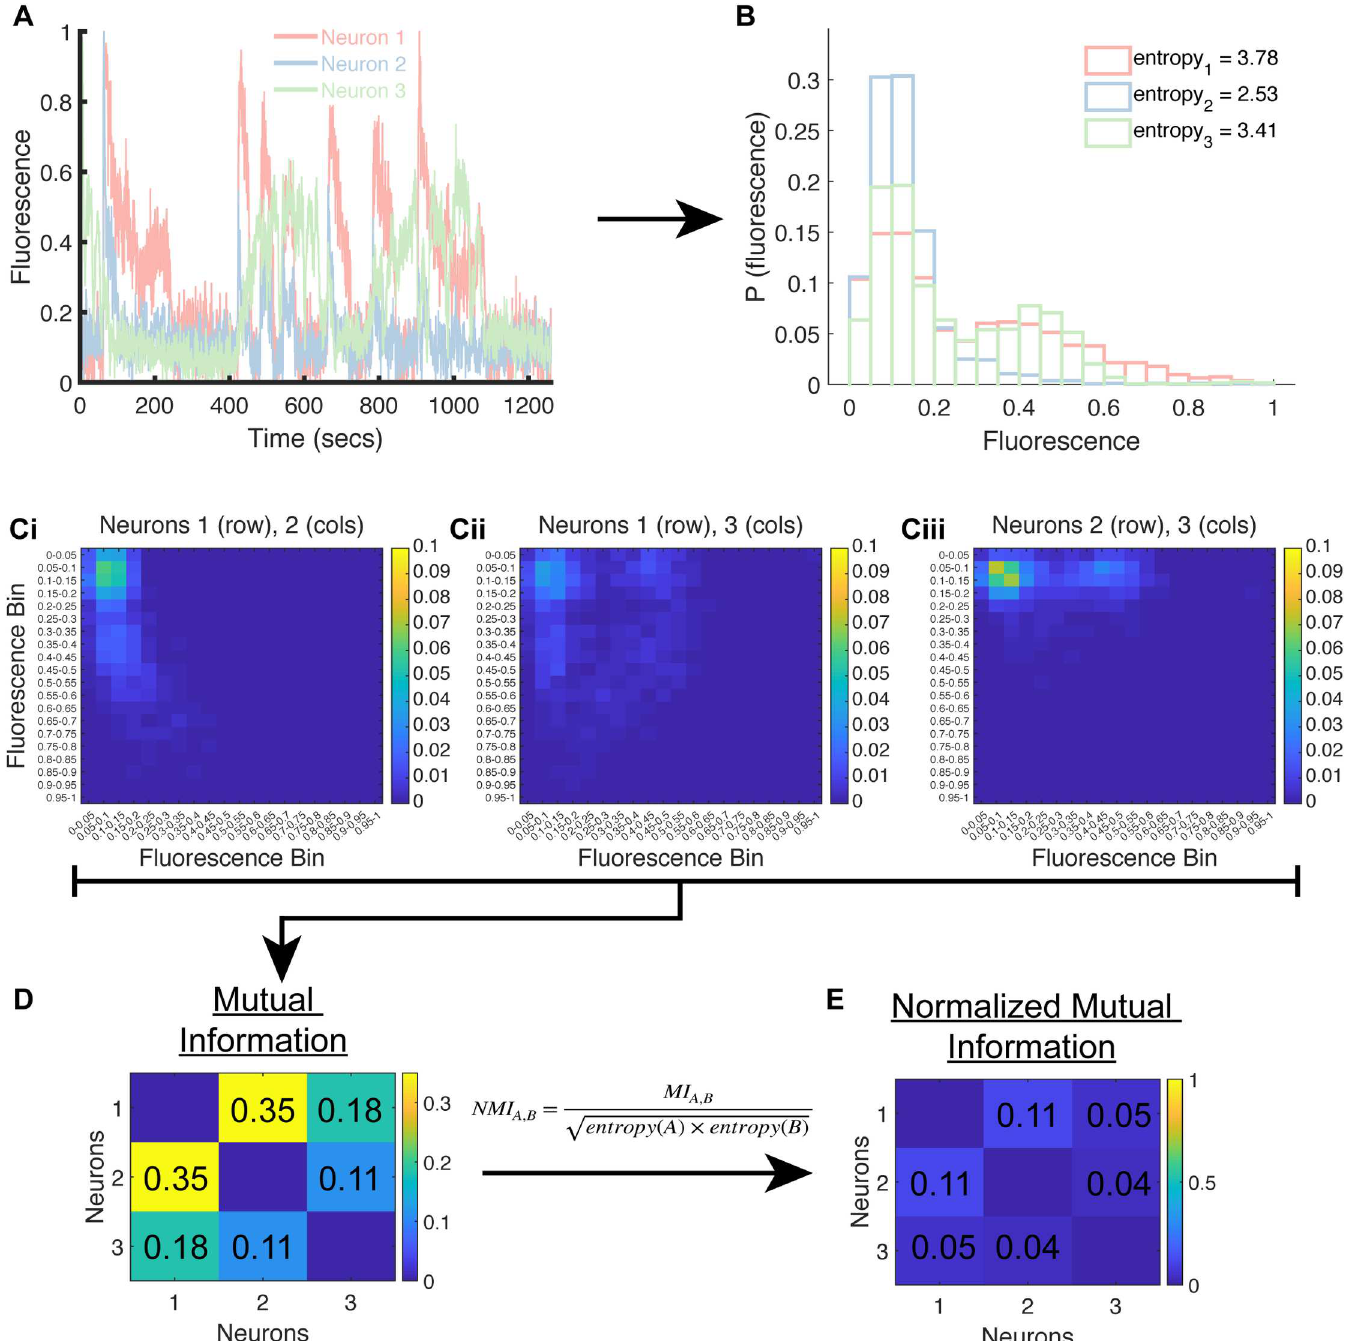
Fig 3. Example of generating an adjacency matrix from the time-series activity of three neurons. A) Activity of three neurons from one worm experiencing 10 − 2 2-nonanone. The three traces are normalized to their max (i.e., each trace is divided by the maximum fluorescence value it achieved in the 21-minute long imaging session). B) Time series are binned into histograms using bins of size 0.05. The legend shows the entropies of the histograms of each neuron from panel A. C) The joint probability distributions of the histograms in panel B for: Ci) Neuron 1 (rows) and Neuron 2 (columns), Cii) Neuron 1 (rows) and Neuron 3 (columns), and Ciii) Neuron 2 (rows) and Neuron 3 (columns). D) The mutual information (MI) between each pair of histograms is computed and then normalized to a maximum of 1 via the equation shown above the arrow, to yield the normalized mutual information (NMI) between each pair of neurons. E) The matrix shown in E is the adjacency matrix used in further graph-theoretic analyses. In this example, we used the entire time series to compute an adjacency matrix, but in our analyses we used 30-second long periods of time.